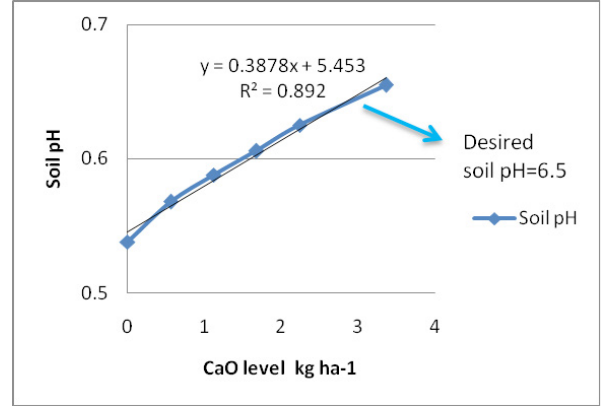
Figure 1. Soil pH plotted against CaO level for Areka soil